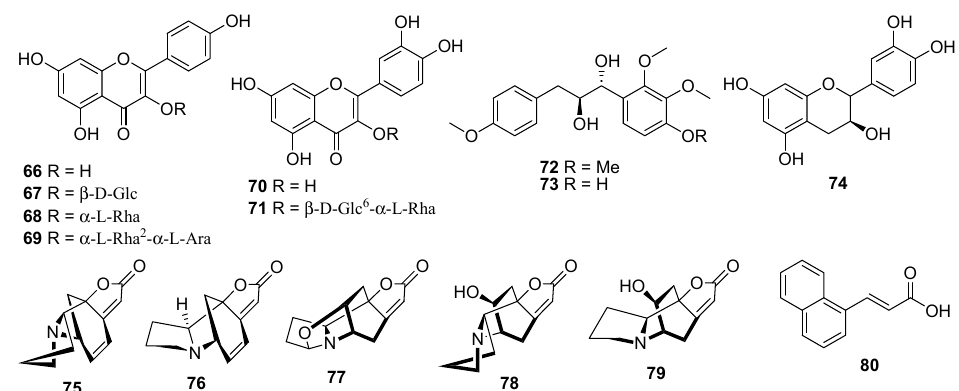
Figure 4. Flavonoids, alkaloids and other compounds from various Phyllanthus species.